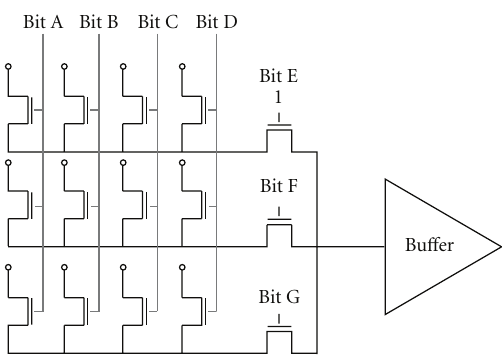
Figure 4: An example of a virtex 4 Routing